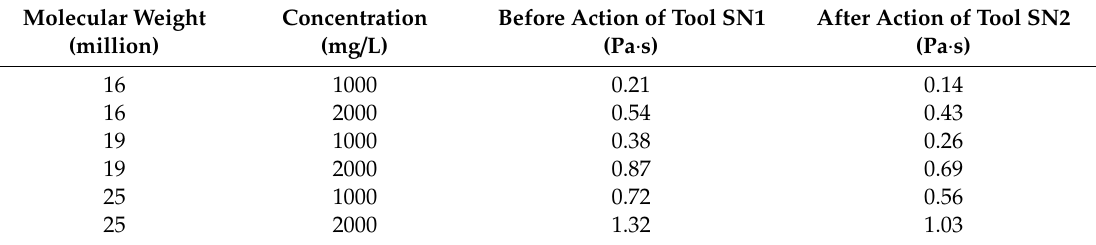
Table 4. Elastic change law of ASP solution before and after flowing through the di ff erent medium tool. Molecular Weight